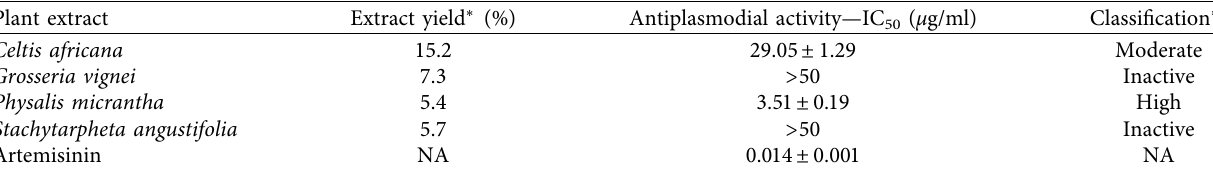
Table 2: Extract yield and in vitro antiplasmodial activity of selected plants against Plasmodium falciparum 3D7 strain. Plant extract